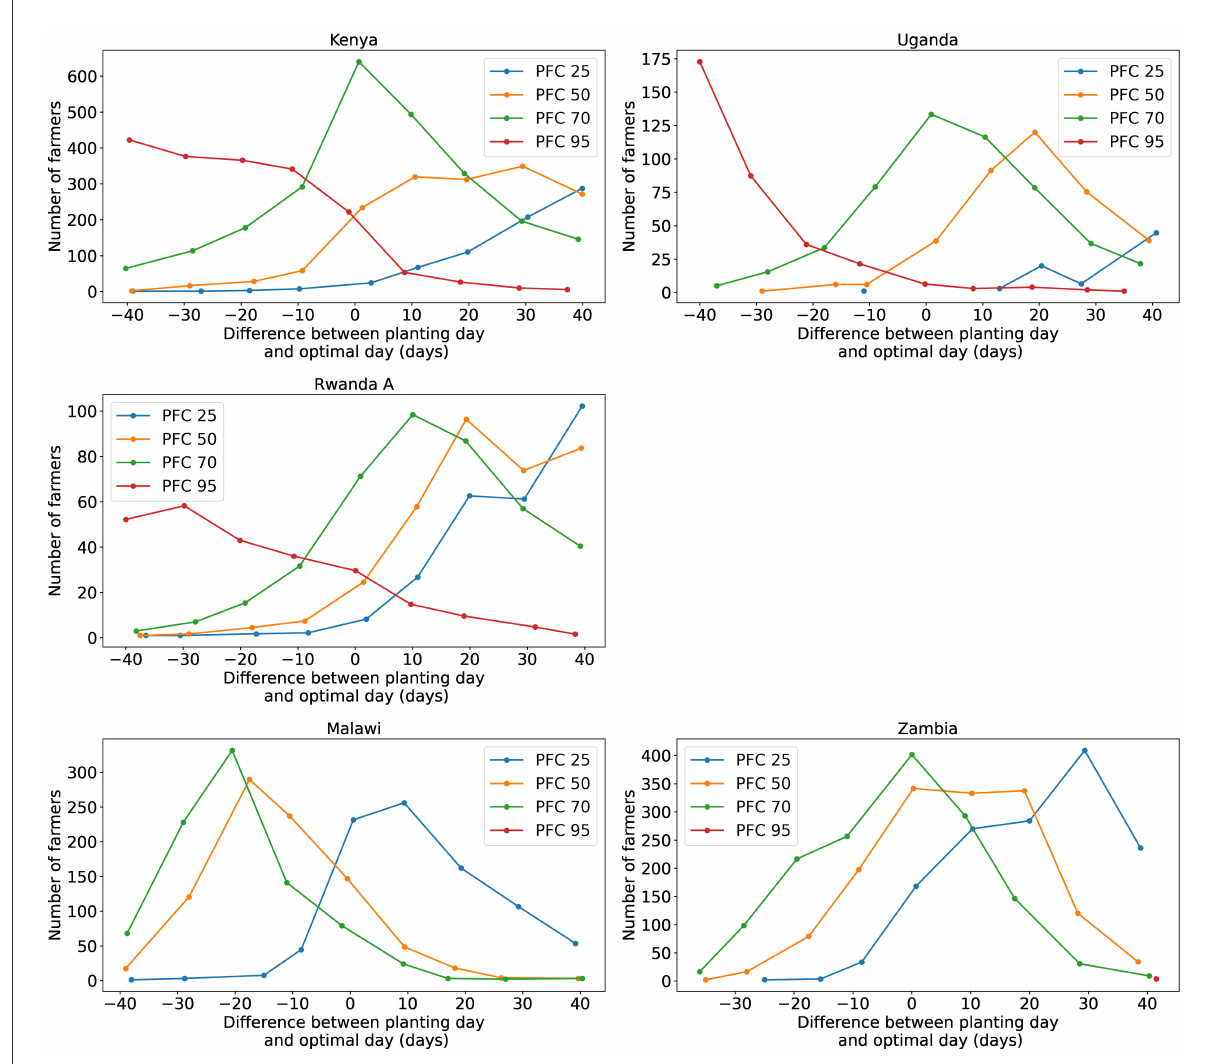
FIGURE4 Number of farmers plotted against the difference between the actual and recommended planting time for all countries and seasons for PFC threshold criterion ranging from 25 to 95%.